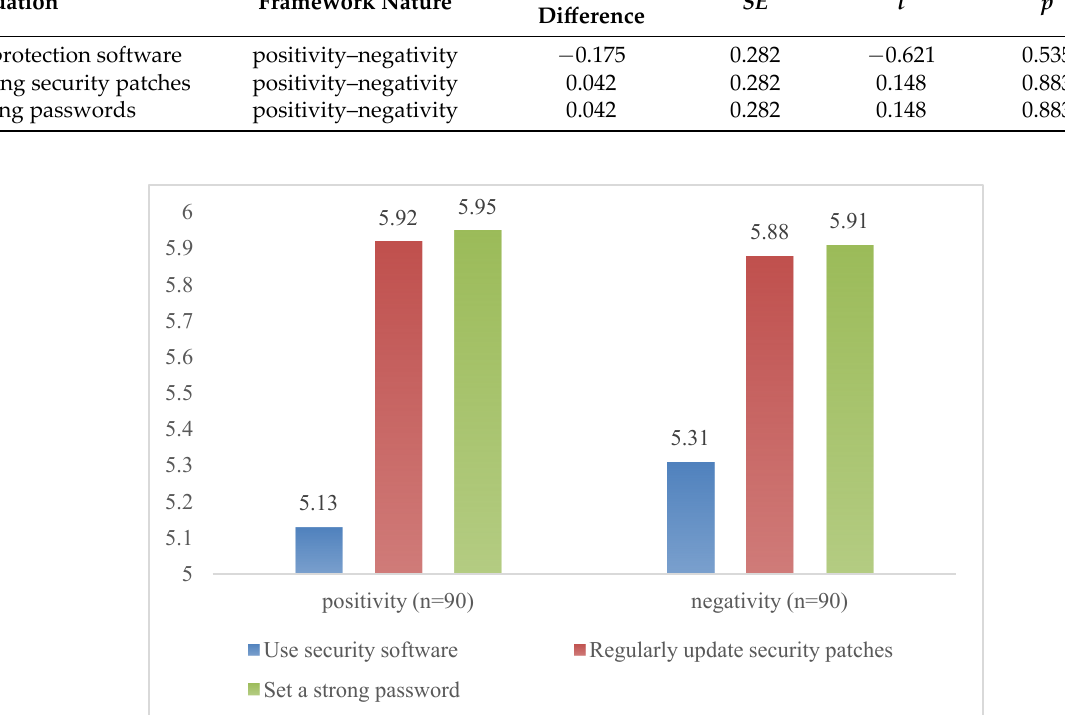
Table 13. Results of Two-Way ANOVA.